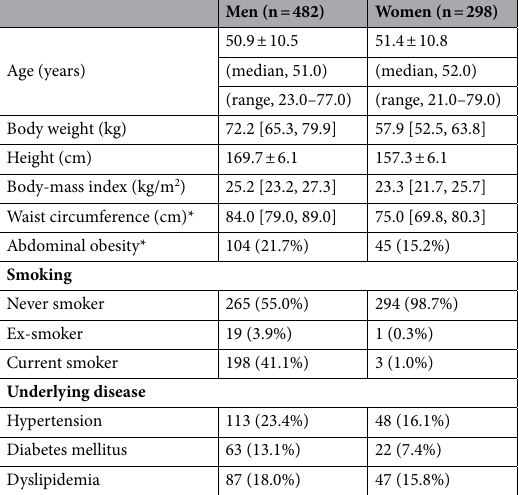
Table 1. Information on 780 individuals taking healthcare screening examination. Numerical variables with normal distribution were provided with mean ± standard deviation, while those not showing normal distribution were provided with median [interquartile range]. Abdominal obesity was defined as a waist circumference ≥ 90 cm in men, and ≥ 85 cm in women. *These values were extracted from 776 individuals consisting of 479 men and 297